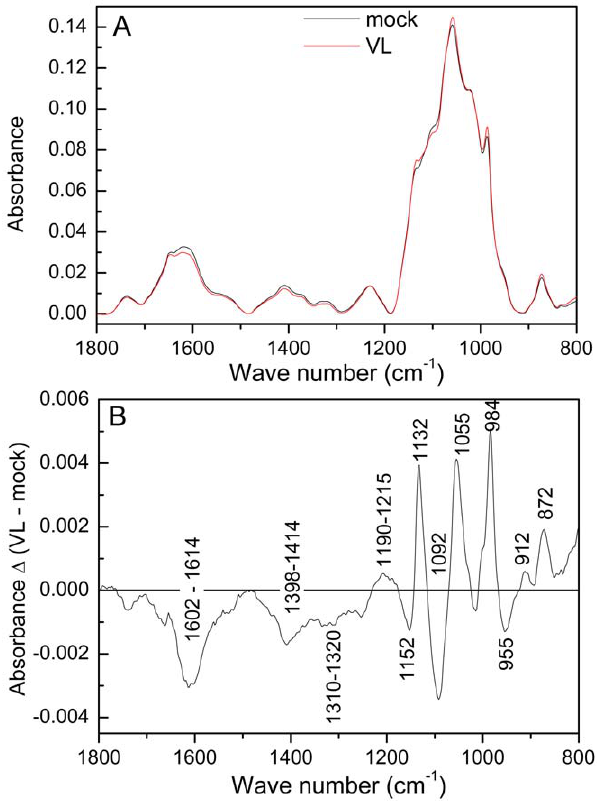
Figure 5. Fourier transform infrared spectra of cell walls of mock- and Verticillium longisporum VL43-infected Arabidopsis thaliana plants (A) and the difference spectrum (B). The difference spectrum was generated by subtracting the mean spectrum of cell walls from mock infected plants from that of VL-infected plants. Spectra were recorded with a resolution of 4 nmandareshown in therange from 800– 1800 cm 2 1 ; data were baseline corrected and vector normalized. Mean spectra were calculated (n=8 per treatment) and subtracted.